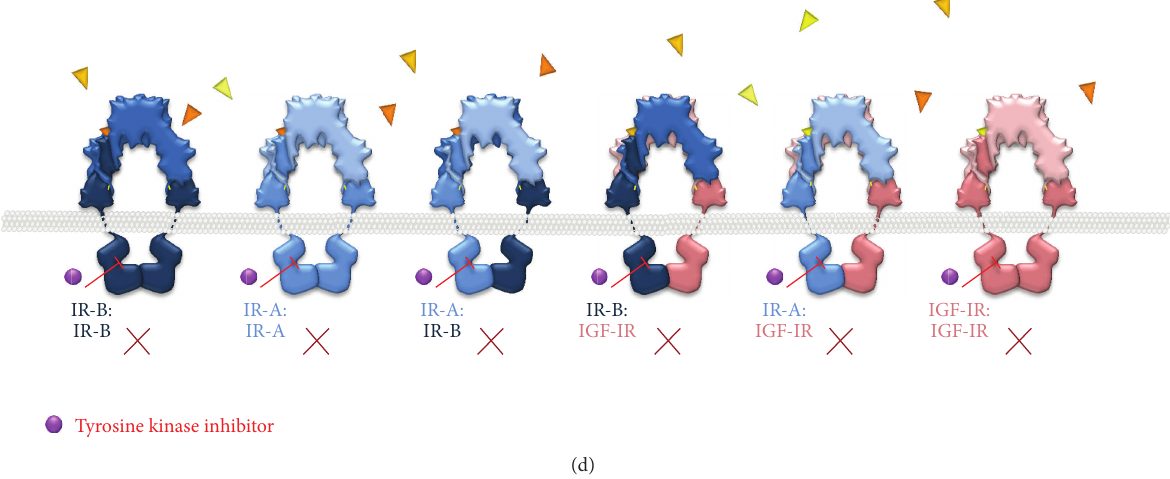
Figure 9: Therapeutic strategies to inhibit insulin, IGF-1, and IGF-2 signal transduction. Graphic representations of the insulin receptor isoform B (IR-B, dark blue), the insulin receptor isoform A (IR-A, lighter blue), and of the type I IGF receptor (IGF-IR, pink) are shown as homodimeric or heterodimeric hybrid receptors. For each receptor monomer, the 𝛼 -chain is coloured slightly lighter than the 𝛽 -chain. Bars indicate the approximate positions of the single disulphide bonds between the C647 in the 𝛼 -chain and C860 in the 𝛽 -chain of each receptor monomer (yellow); the single disulphide bond between the FnIII-1 domains of each of the two 𝛼 chains in each dimer is obscured. The extracellular ligands, insulin (orange), IGF-2 (ochre), and IGF-1 (pale yellow), are shown as triangles. The downward pointing grey arrows indicate that a signal has been transduced from a receptor dimer (a). The deep yellow spheres attached to the ectodomains of the activated receptors represent phosphorylated residues. Antibodies against IGF-1 and IGF-2 (IGF mAb; yellow), and recombinant insulin-like binding protein as an incomplete sphere (rIGFBP; light blue), are shown. Inhibition of a signal transduction molecule that is affected by one of the inhibitors is indicated by an inhibition symbol (brick red). Absence of a signal from a receptor dimer is indicated by a red cross below the receptor dimer (b). Monoclonal antibodies against IGF-1 and IGF-2 will not inhibit insulin signal transduction. Recombinant IGFBP will inhibit IGF-1 and IGF-2 but will not inhibit insulin. Antibodies specific for type I IGF receptor are shown (Type I IGF receptor mAb; deep pink) (c). Antibodies specific for the type I IGF receptor will inhibit type I IGF receptor homodimer and its hybrid receptors formed with both isoforms of the insulin receptor but will not inhibit insulin receptor homodimers or hybrids of the two isoforms of the insulin receptor. Representations of tyrosine kinase inhibitors (TKIs) that inhibit both the insulin and type I IGF receptors (tyrosine kinase inhibitor; violet) are illustrated (d). Tyrosine kinase inhibitors that affect type I IGF receptor and the insulin receptor will inhibit signal transduction via all the insulin and IGF signal transduction pathways. Tyrosine kinase inhibitors that are specific for the type I IGF receptor will inhibit the type I IGF receptor homodimer and its hybrid receptors but will not inhibit insulin receptor homodimers or hybrids of the two